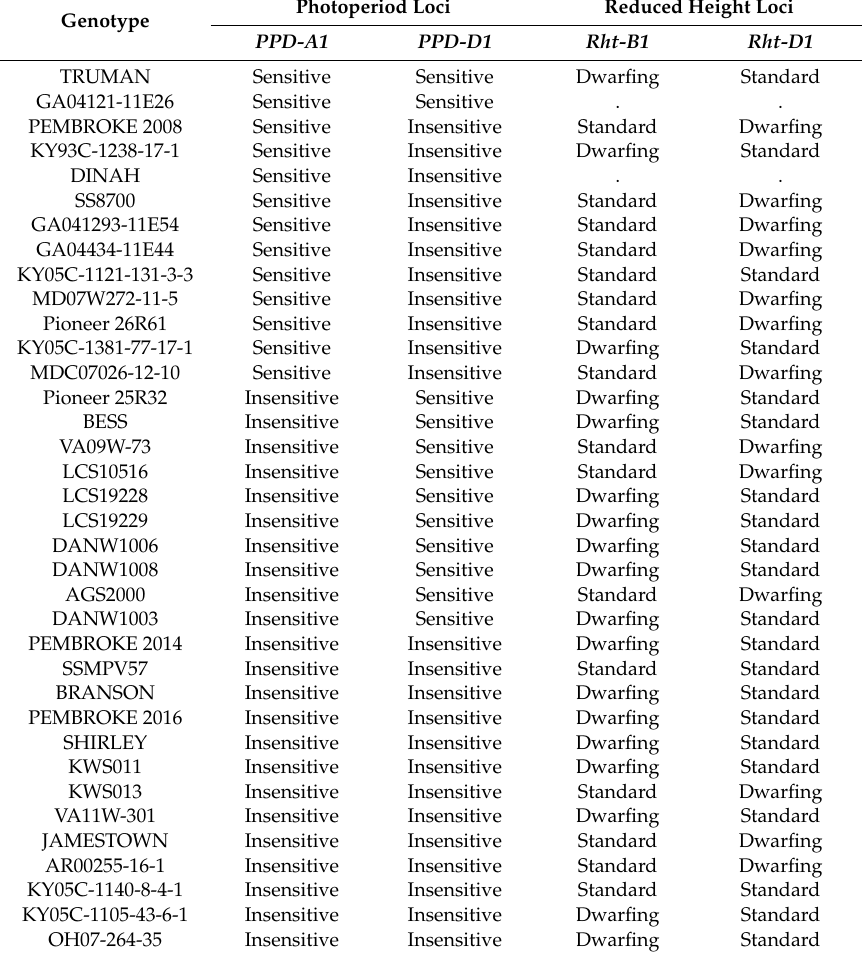
Table 1. Panel of 36 soft red winter wheat genotypes with photoperiod ( PPD ) and reduced height ( Rht ) classification determined by marker analysis at two PPD and Rht loci. These lines were tested under control and passively warmed environments, 2015–2016 growing seasons, Lexington,